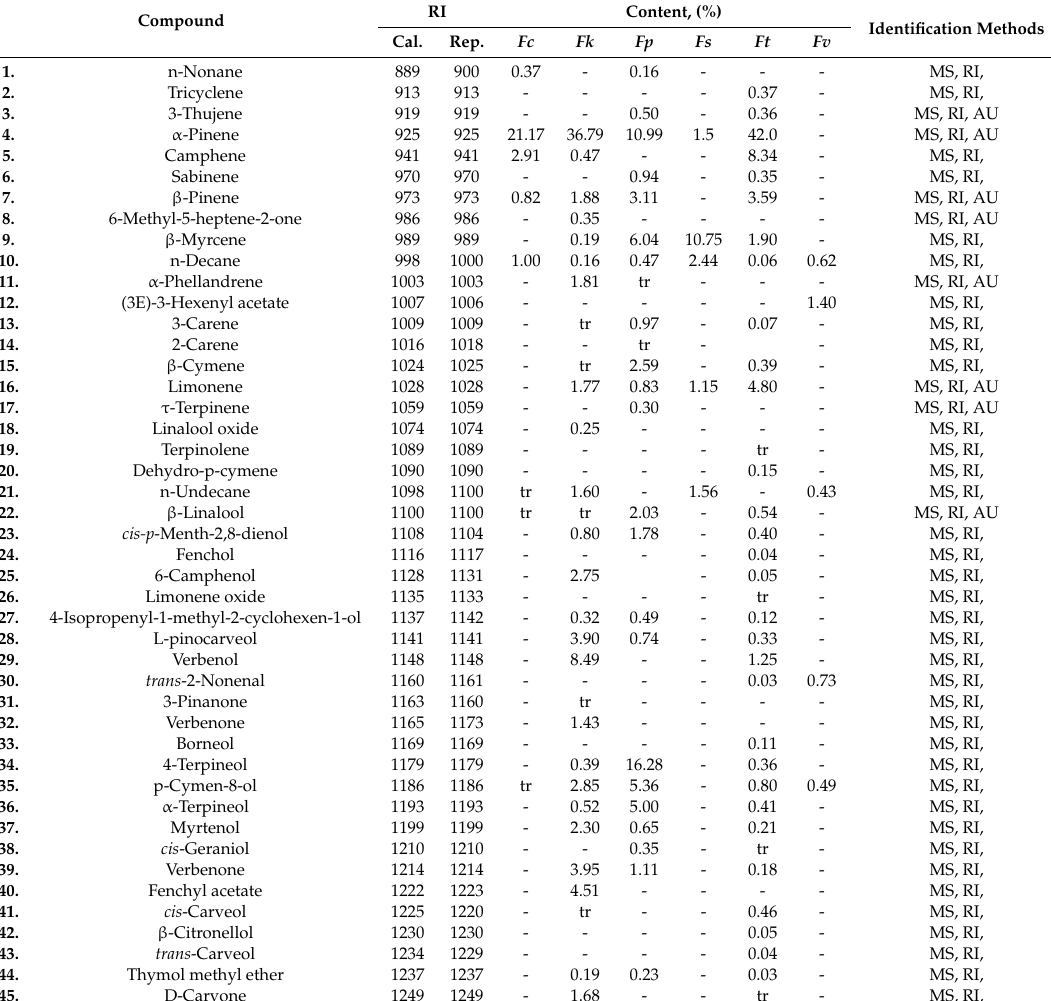
Table 1. Composition of volatile oil in the aerial parts of F. caratavica ( Fc ), F. kuchistanica ( Fk ), F. pseudoreoselinum ( Fp ), F. samarcandica ( Fs ), F. tenuisecta ( Ft ) and F. varia ( Fv